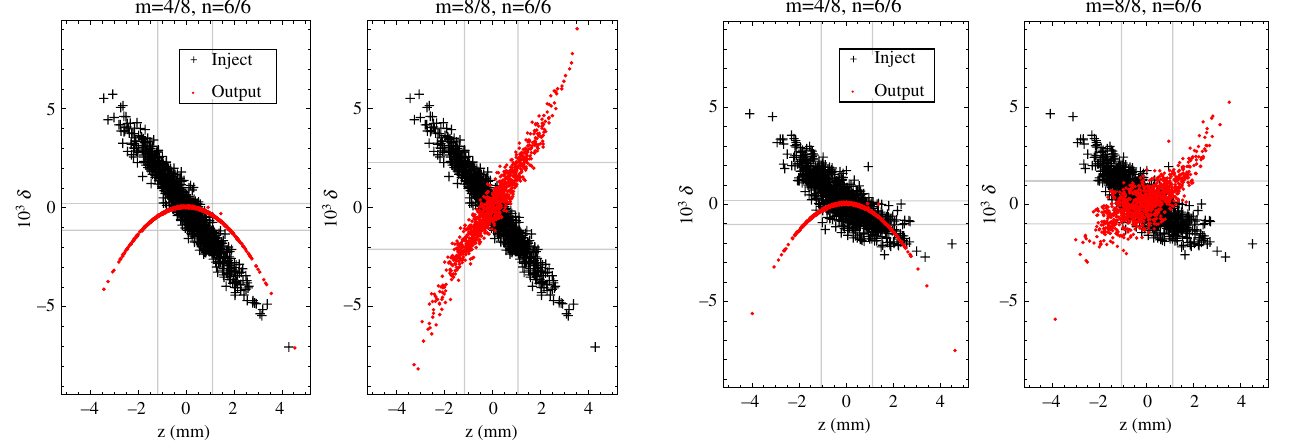
FIG. 6. Tilted 1000-particle beam in the UR model after full acceleration (left), and at beam stop (right), where the beam tilt is determined by scanning through injector phases until the one that yields the most symmetric input/output σ δ is found. Note that the center of the final distribution after the ERL is a mirror image of that before entering the accelerator. This symmetry also deter- mines that the slope of the distribution is zero at its center after half the ERL has been